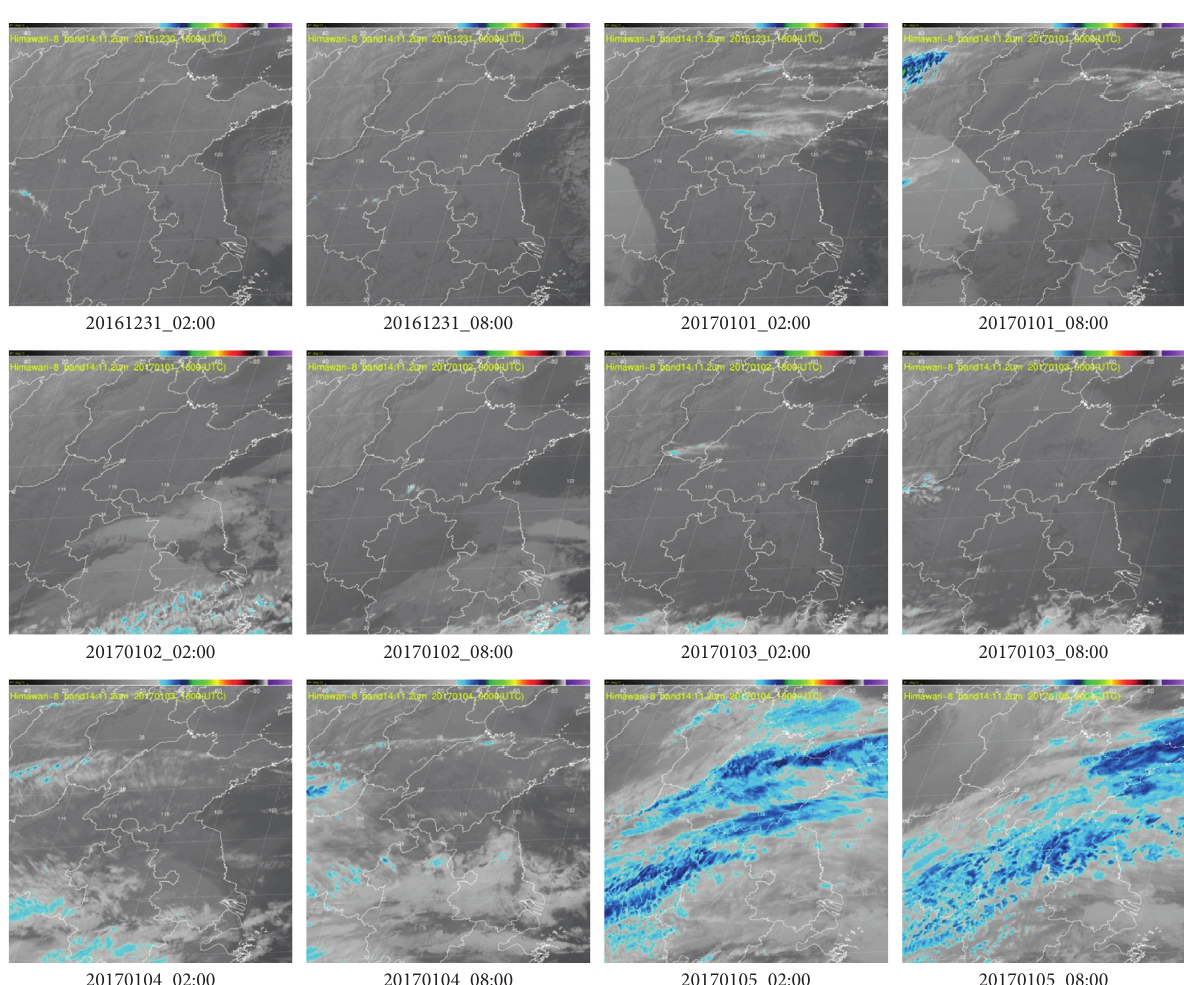
Figure 6: Himawari-8 satellite 11.2 μ m channel cloud image at 02:00 and 08:00 every day from December 30, 2016, to January 5,